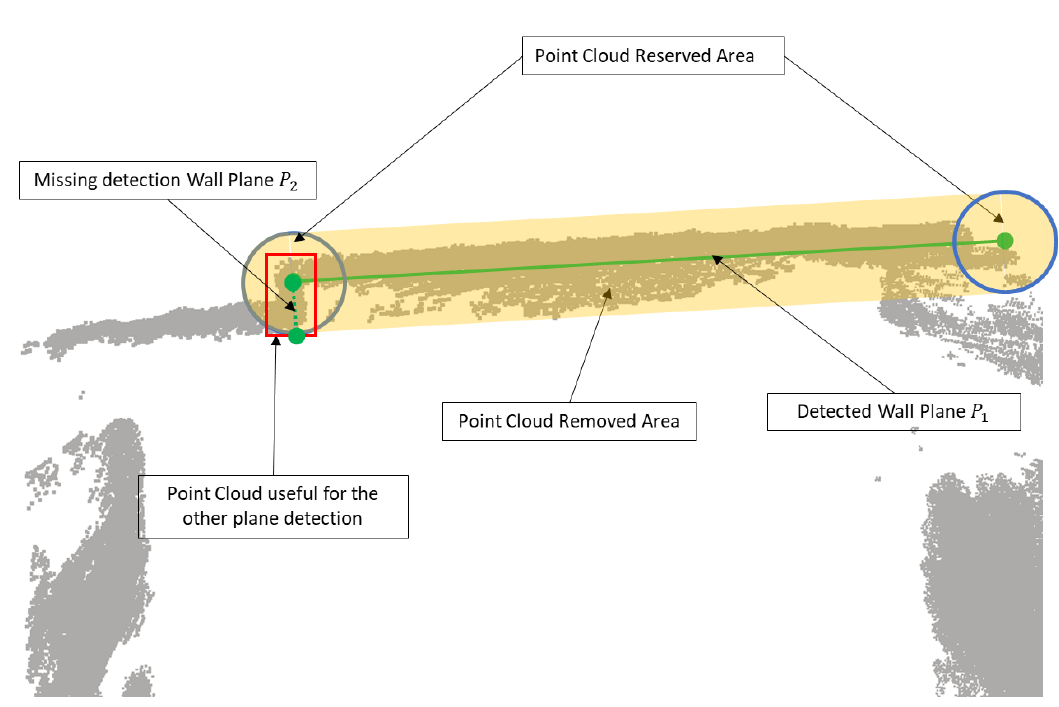
Figure 8. Description of the over-detection problem and the solution used in this paper.